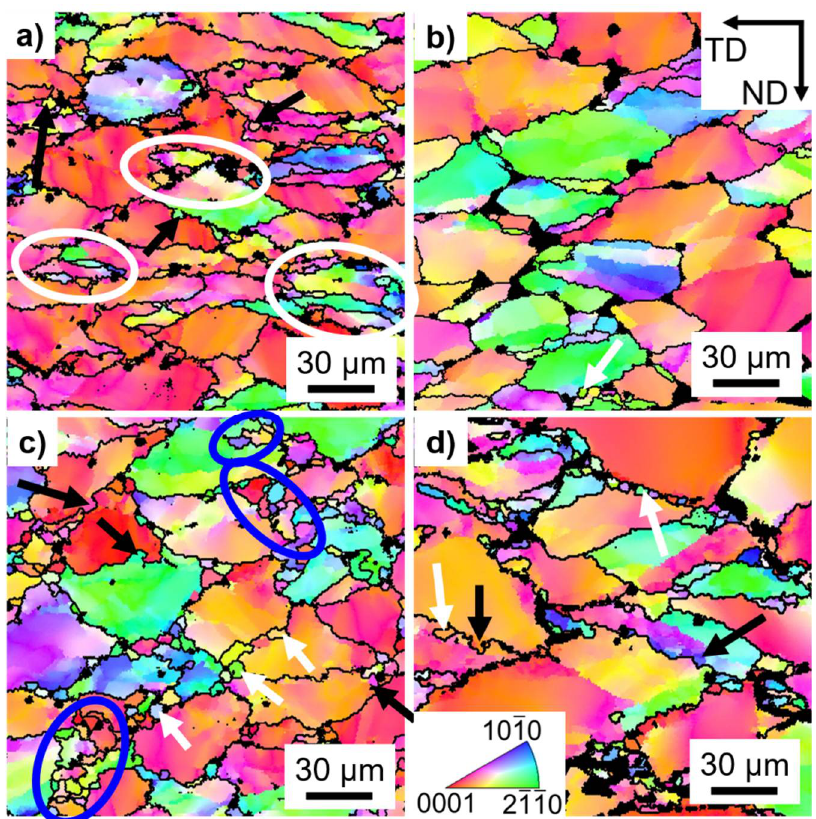
Figure 12. Inverse pole figure maps for the deformed alloys at 0.0001 s −1 and: ( a ) 250 °C, ( b – d ) 300 °C; for the: ( a , b ) ZK40; ( c ) ZK40-CaO; ( d ) ZK40-Gd. Only α-Mg is indexed. Non-indexed regions are highly deformed regions or intermetallic compounds. Black lines indicate high angle grain boundaries. Black arrows indicate small grains at prior grain boundaries. Blue ellipses indicate regions that resemble a twin shape and also new grains. ND and TD indicate the compression and transversal directions, respectively.